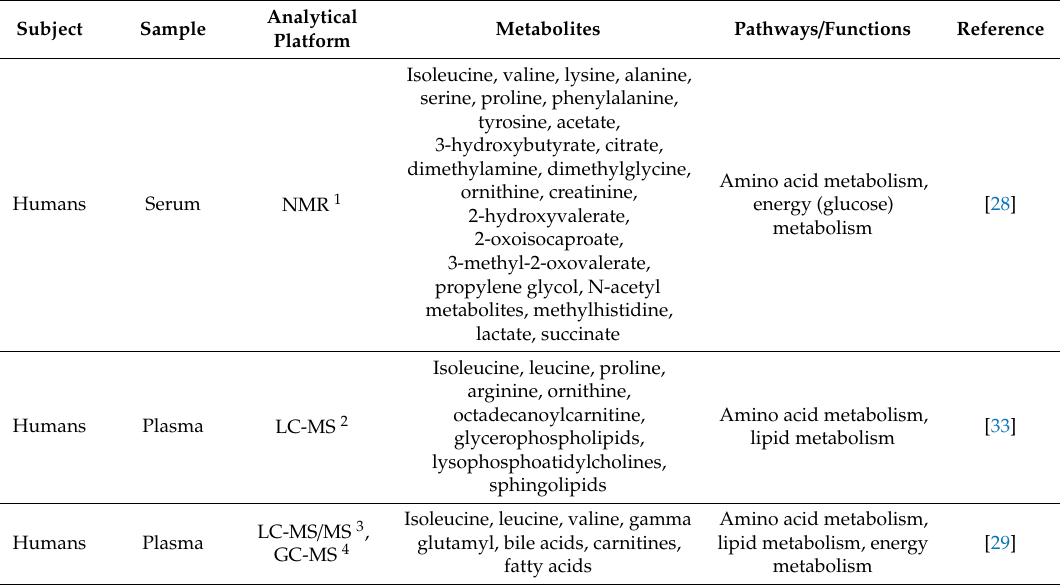
Table 1. Identified insomnia